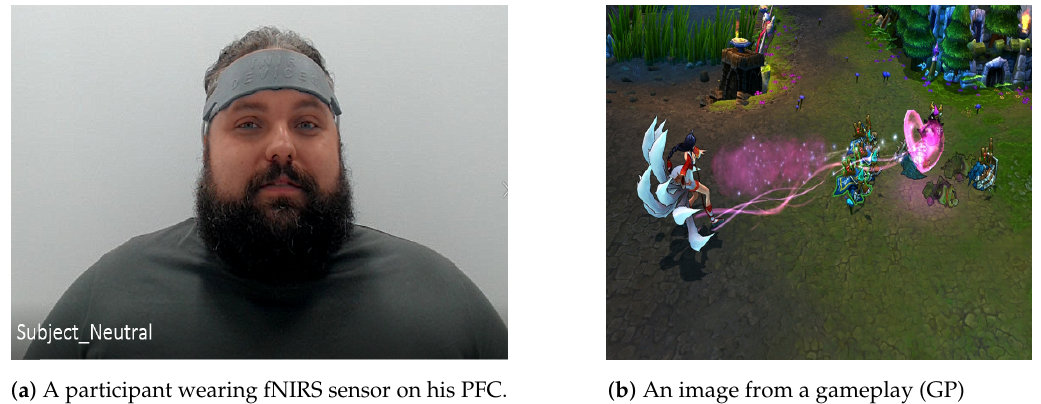
video. Figure 4. ( a ) A participant watching a ( b ) gameplay (GP) video whilst his brain activity is recorded using a fNIRS sensor